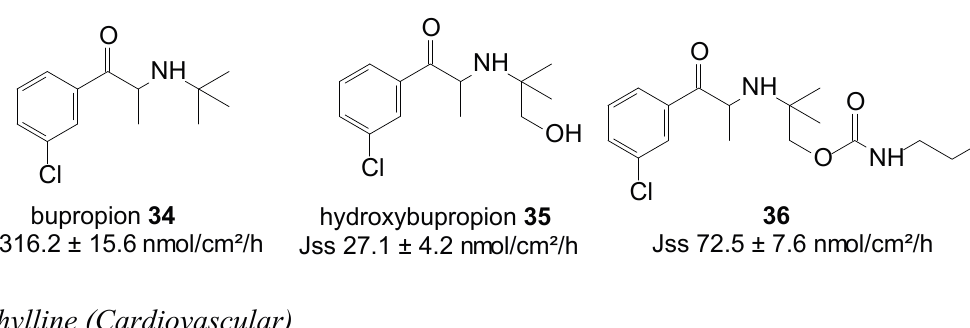
NHO NHO NHO OH O Cl Cl 36 hydroxybupropion 35 Jss 72.5 ± 7.6 Jss 27.1 ± 4.2 nmol/cm²/h